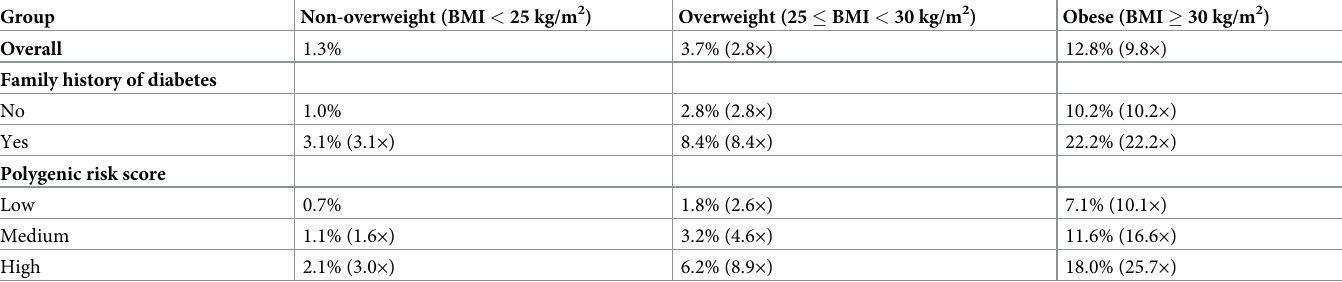
Table 1. Prevalence of diagnosed type 2 diabetes in the self-reported white British UK Biobank cohort, stratified by BMI, family history, and polygenic risk score. Group Overall Family history of diabetes No Yes Polygenic risk score Low 0.7% Medium High Relative risks with respect to the lowest-risk (top left) category in each stratification are shown in parentheses. Because prevalences within our cohort are by definition exact, we do not report confidence